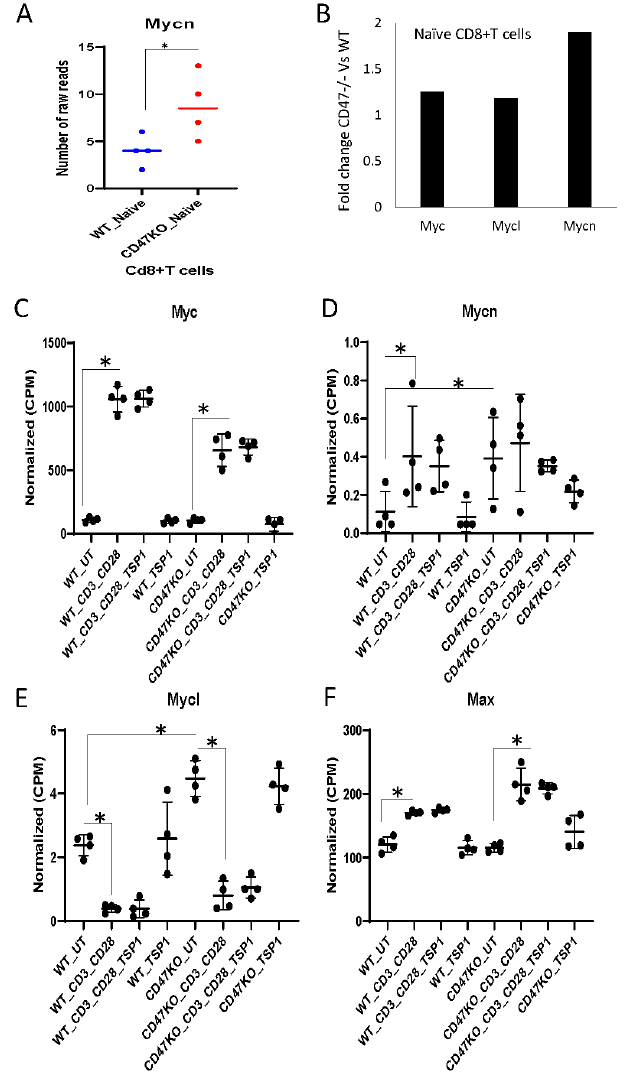
Figure 2. CD47-dependent regulation of Myc family genes by activation and TSP1 in mouse CD8 + T cells. ( A ) Expression of Mycn mRNA in naïve WT and cd47 − / − mouse CD8+ T cells. ( B ) Fold change of selected Myc family genes (Myc, Mycn, and Mycl) in cd47 −/− as compared to naïve WT mice (unpublished). WT CD8 + T cells extracted from RNA sequencing raw reads. ( C–F ) mRNA expression of Myc, Mycn, Mycl, and Max (normalized CPM) from WT and cd47 −/− CD8 + T cells that were activated with anti-CD3 plus anti-CD28 antibodies and treated in the presence or absence of TSP1 for 6 h. Error bars indicate independent biological replicates ( n = 4).